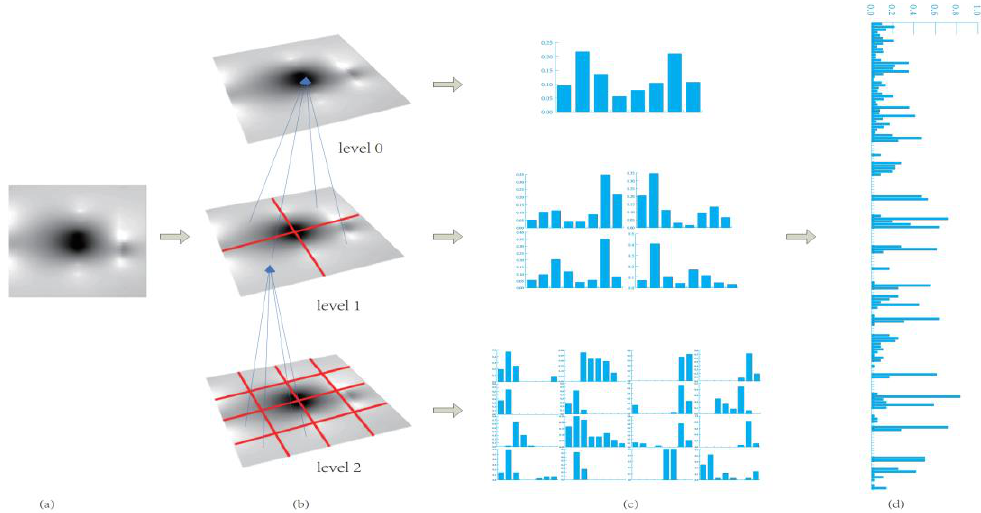
Figure 5 Schematic diagram of HMA constructed based on spatial pyramid